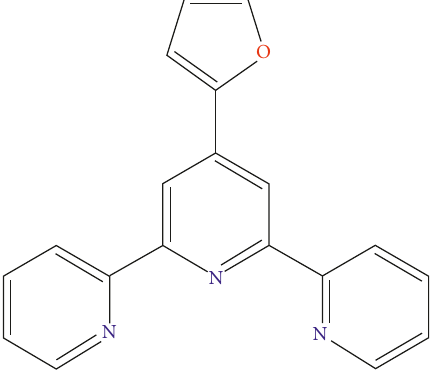
Scheme 1: The chemical structure of L